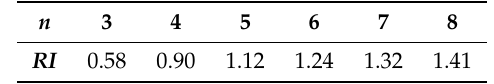
Table 3. The random index value ( RI ) of n